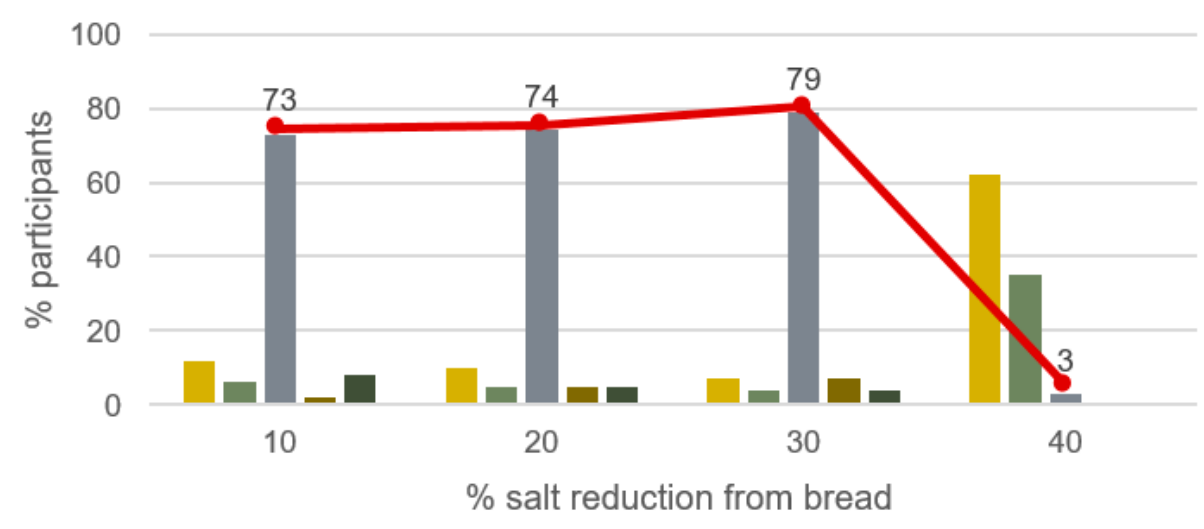
Figure 3. Saltiness perception of salt reduced bread by Tunisian consumers.